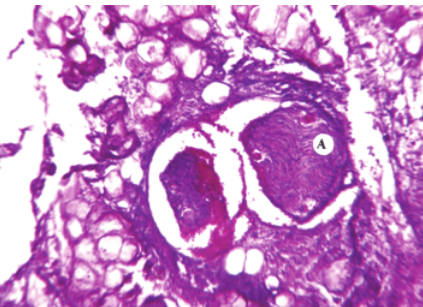
Figure 5: PAS-positive substance accumulation (A) in zones of fibrinoid necrosis. PAS reaction for neutral mucopolysaccharides ( × 100).